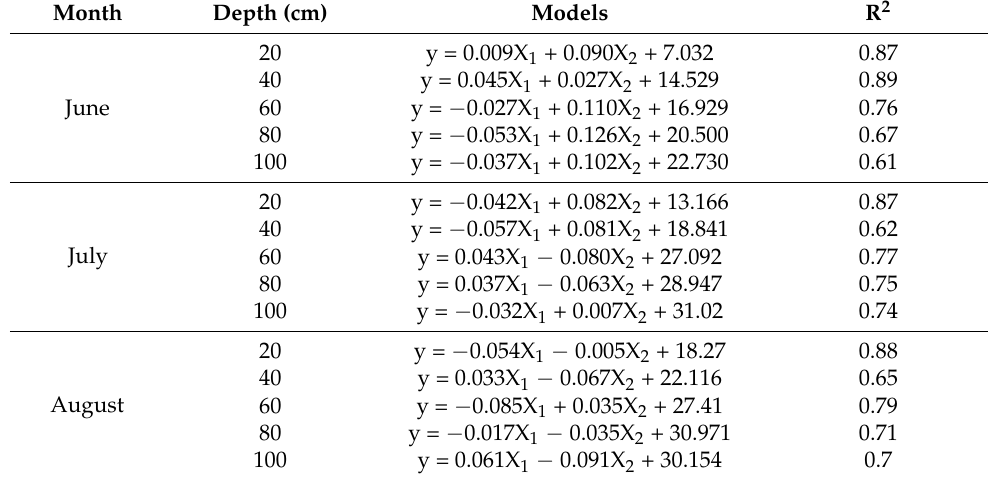
Table 2. Predicted relationships of soil-water content at different depths and